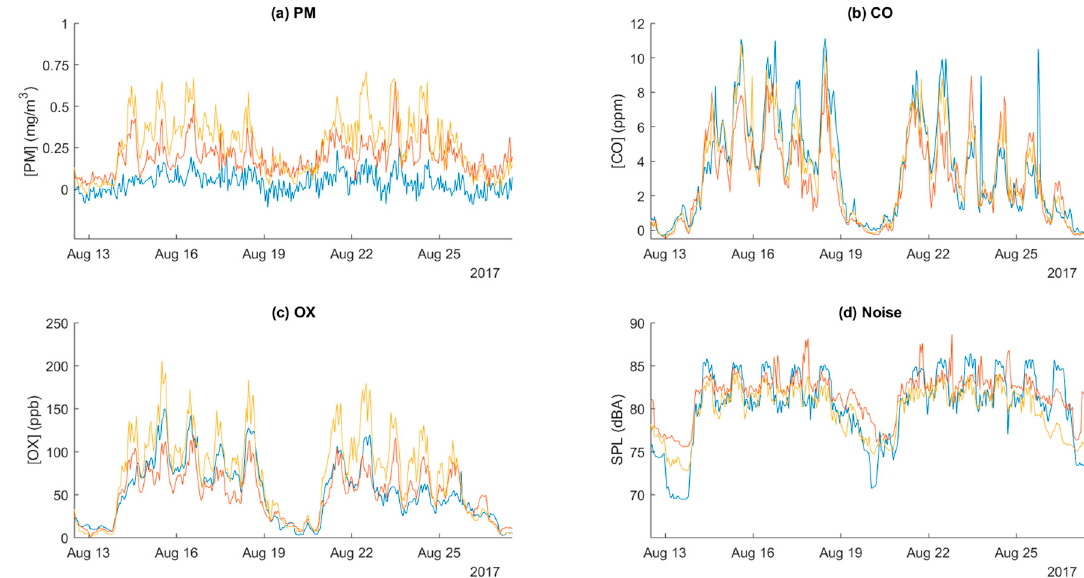
Figure 12. Timeseries plots of ( a ) PM, ( b ) CO, ( c ) oxidizing gases, and ( d ) noise recorded by three monitors at different locations over several days. The two larger patterns indicate work weeks, with hazards being lowest during the weekends. Small peaks within the work week indicate diurnal variation. Differences between the colored lines in a single plot indicate differences caused by the location of the monitors within the factory.